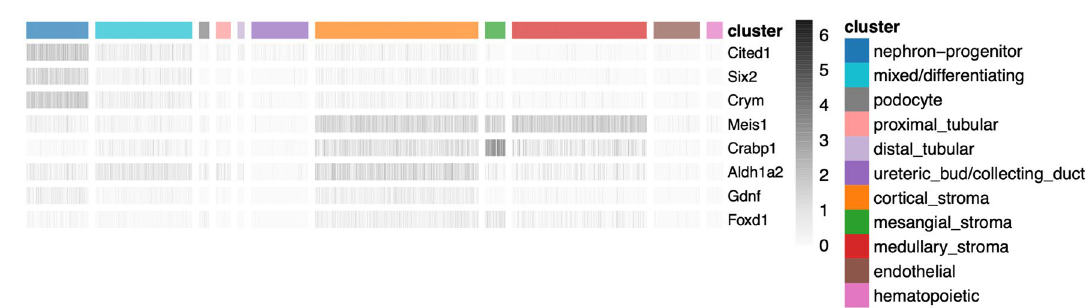
Figure 5. Expression of lineage-marker genes in unexpected cell types. Heatmap of gene expression (gray scale) of known lineage marker genes (rows) across cells (columns), ordered by cell clusters (color index). We observe the expression of cap mesenchyme markers ( Cited1 , Six2 , Crym, Gdnf ) in stromal cells and vice versa, consistent with previous reports 27